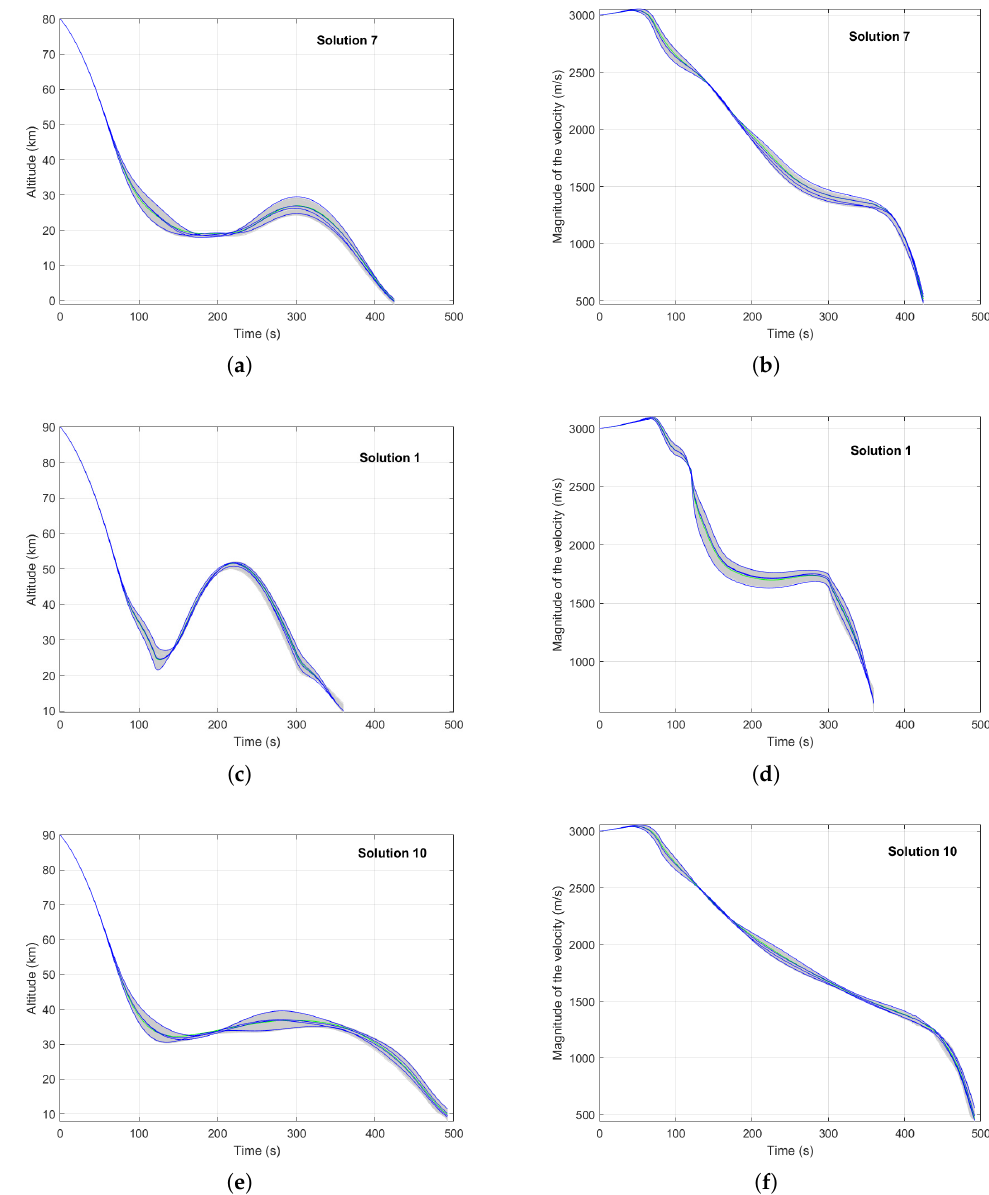
Figure 10. Monte Carlo analysis for Solution 7 ( a , b ), Solution 1 ( c , d ) and Solution 10 ( e , f ). Green is the central Sigma point 0, blue are Sigma points 1–4, and grey lines are the 100 Monte Carlo samples. ( a ) Altitude, Solution 7; ( b ) Velocity, Solution 7; ( c ) Altitude, Solution 1; ( d ) Velocity, Solution 1; ( e ) Altitude, Solution 10; ( f ) Velocity, Solution